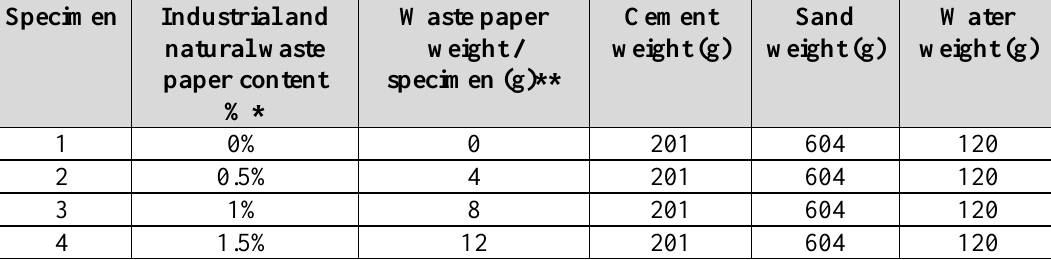
Fig. 5: Bending test specimens. Table 3: The composition of the cuboidal